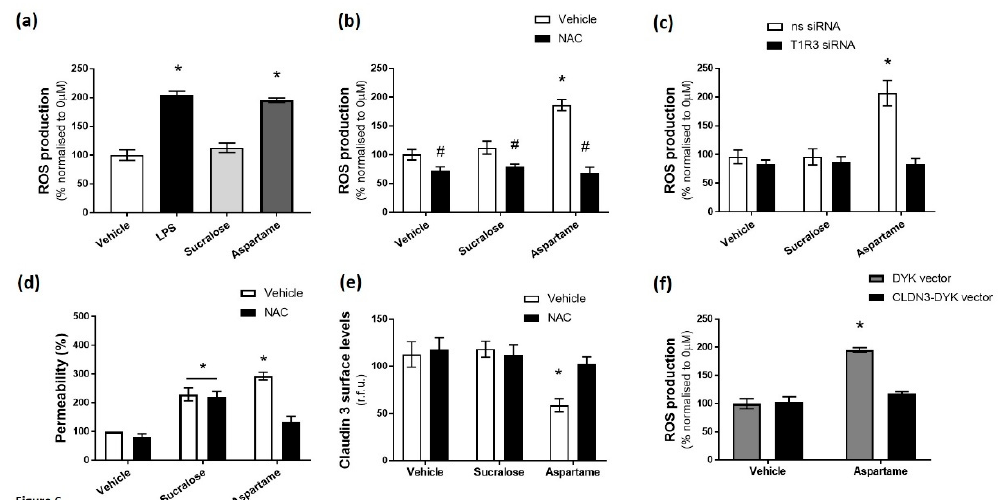
Figure 6. Aspartame, but not sucralose, increases oxidative stress in intestinal epithelial cells linked to barrier leakage. Reactive oxygen species (ROS) production in Caco-2 cells was measured by fluorescence of DCFDA following exposure to sucralose or aspartame (0.1 mM) or LPS (1 µ g / mL) as a positive control ( a ) in the presence and absence of the anti-oxidant N-acetyl cysteine (NAC; 1 mM) ( b ) or following siRNA knockdown of T1R3 ( c ). ( d ) The permeability of the Caco-2 cell monolayer was measured by an FITC-dextran assay, following exposure to sucralose and aspartame (0.1 mM) for 24 h in the presence and absence of NAC. % permeability was calculated normalized to vehicle treatment. ( e ) The cell surface expression of claudin 3 was determined by whole-cell indirect ELISA using chemiluminescence in Caco-2 cells exposed to sucralose or aspartame (0.1 mM) in the presence and absence of NAC. ( f ) ROS production was measured by fluorescence of DCFDA in Caco-2 cells transiently transfected with CLDN3-DYK or control vector, exposed to aspartame (0.1 mM). % permeability was calculated normalized to vehicle treatment. ROS production was calculated as % normalized to 0 µ M. n = 5–6. Data are expressed as mean ± S.E.M. * p < 0.05 versus vehicle (0 µ M); # p < 0.05 versus vehicle for NAC.